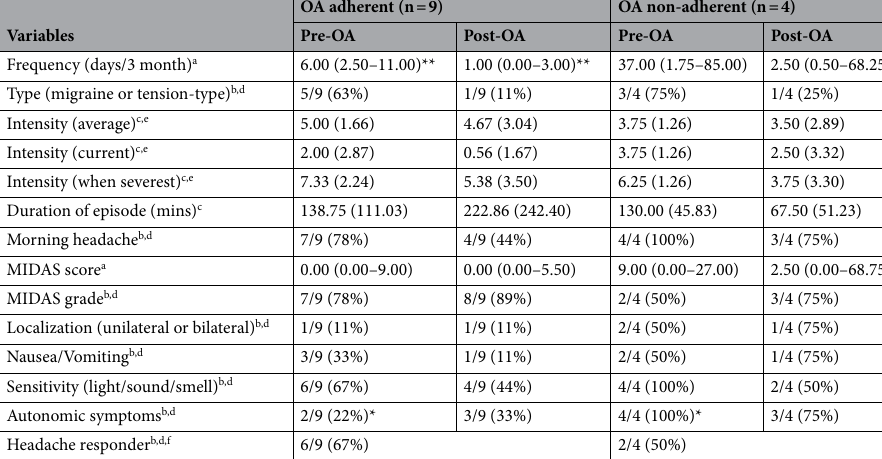
Table 5. Headache characteristics according to oral appliance adherence group. OA oral appliance. *Significant difference: P < 0.05, comparison between OA adherent and non-adherent. **Significant difference: P < 0.05, comparison between pre- and post-oral appliance treatment. a Differences between groups were tested with Mann–Whitney test and pre- and post-OA data were tested with Wilcoxon Rank-sum test: Median (lower quartile-upper quartile). b Differences between groups were tested with Chi-square test and pre- and post-OA data were tested with McNemar’s test. c Differences between groups were tested with t-test and pre- and post-OA data were tested with paired t-test: Mean (SD). d Results given as number of patients with migraine, morning headaches, low disability, unilateral headache, nausea (vomiting), sensitivity, autonomic symptoms, headache responder/total number of patients (percentage of patients with each characteristic). e Based on a visual analog scale, 0 (no pain) − 10 (worst pain imaginable). f Those with ≥ 30% reduction in headache frequency were considered headache